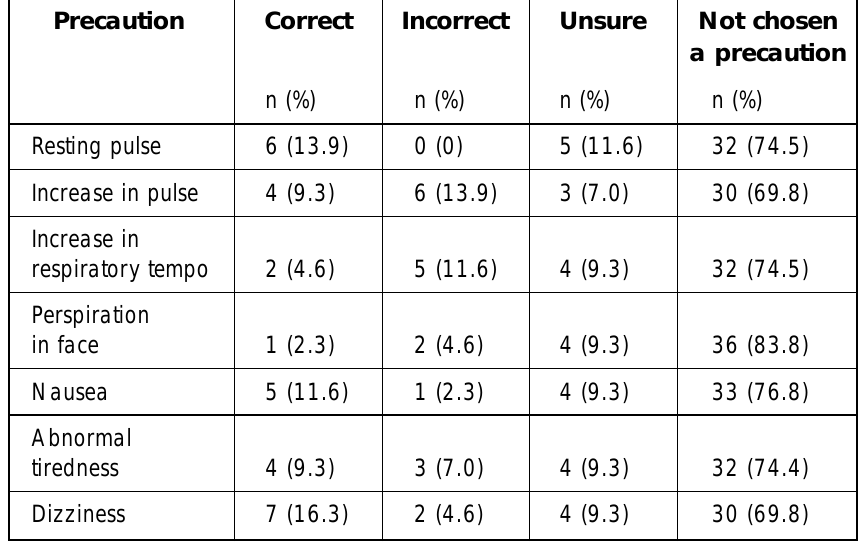
Table 1:Responses to precautions taken during exercise.